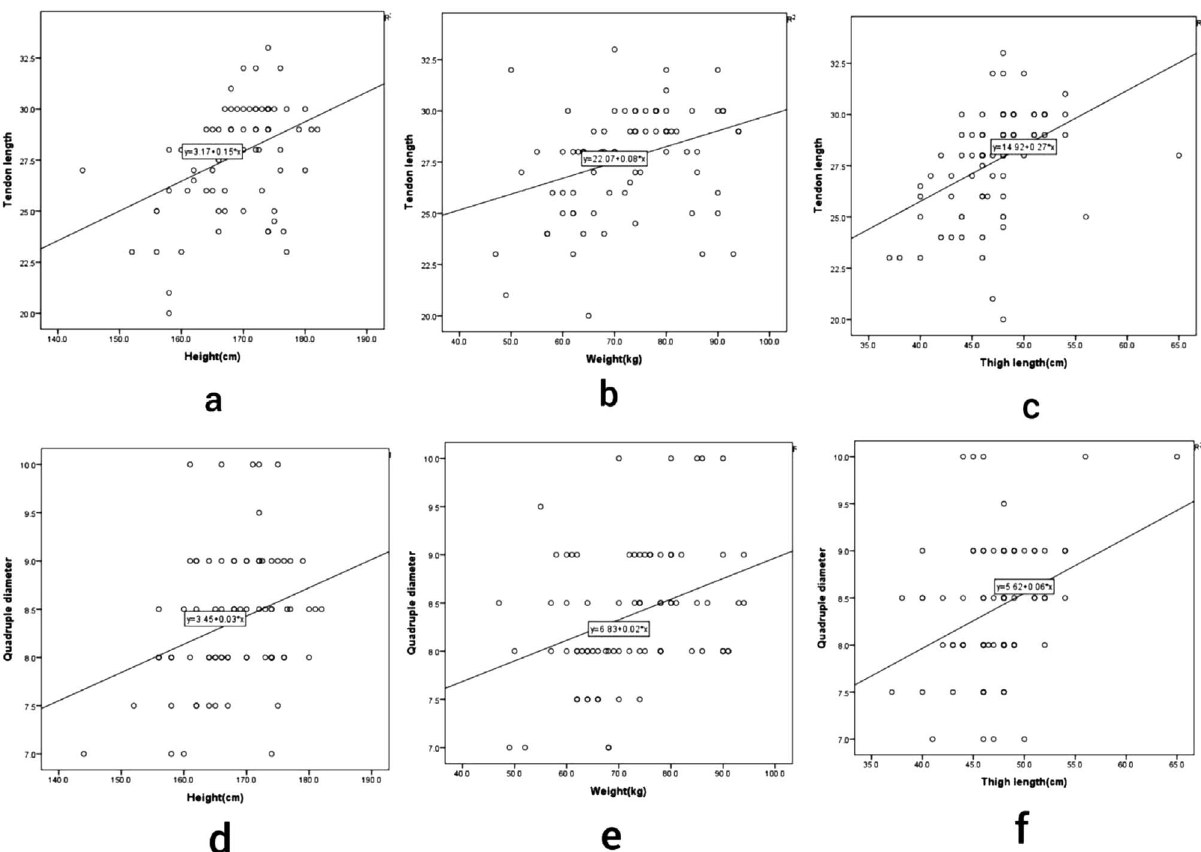
Figure 2. Scatter plots showing correlations of tendon length to height (a), weight (b) and thigh length (c) and also correlations of quadruple diameter to height (d), weight (e) and thigh length